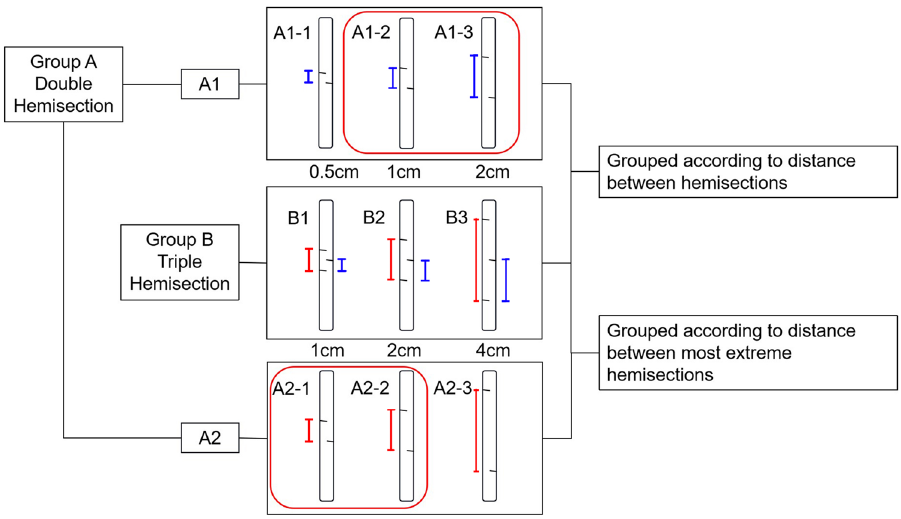
Figure 2. Schematic diagram of Group A and Group B. The red line represents the distance between the two farthest hemisections, whereas the blue line represents the distance between the hemisections. Group A was the double-hemisection group and Group B was the triple-hemisection group. Group A1 was divided into A1-1, A1-2 and A1-3 groups, corresponding to the distance between hemisections of 0.5, 1, and 2 cm, respectively. Group B was divided into B1, B2, and B3, corresponding to distances of 0.5, 1 and 2 cm between hemisections, respectively. Because of the different distances between the farthest hemisections and the possibility that the